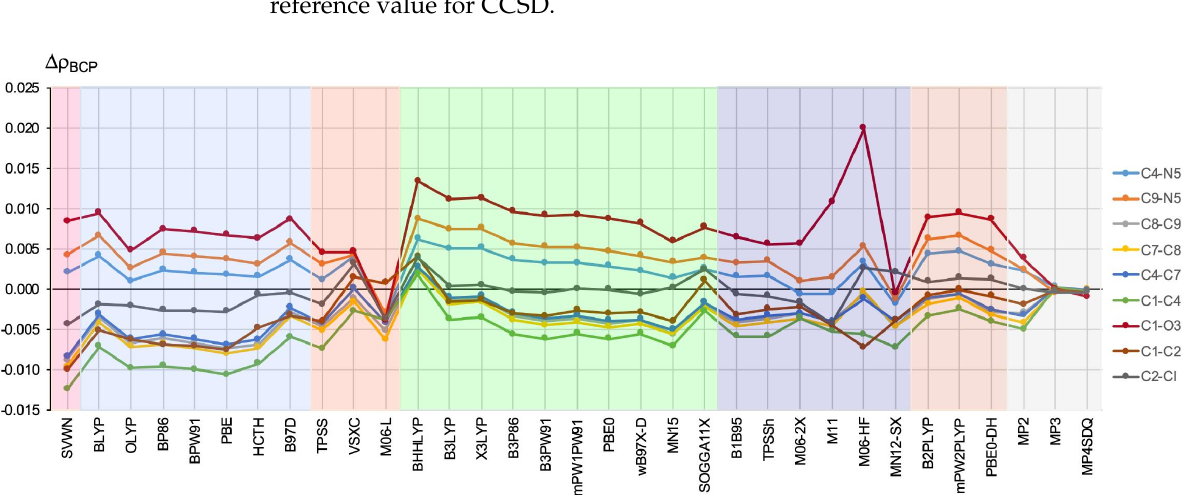
Figure 2. The difference (in relation to the CCSD method) in the value (in a.u.) of the elec- tron density determined at the bond critical point of the bond shown on the right side of the figure. The different types of methods are represented by a colored background: LDA—pink, GGA—blue, M-GGA—orangeish, H-GGA—green, HM-GGA—violet, DH-GGA—beige, and pertur- bational